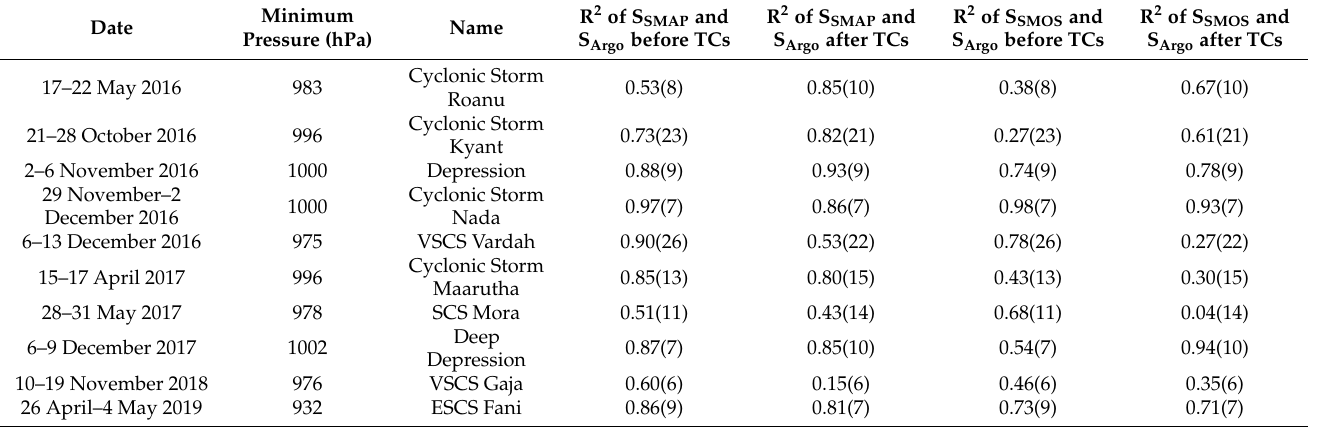
Table 1. Basic information about 10 TCs and correlations between S SMAP , S SMOS, and S Argo before and after TC passage in